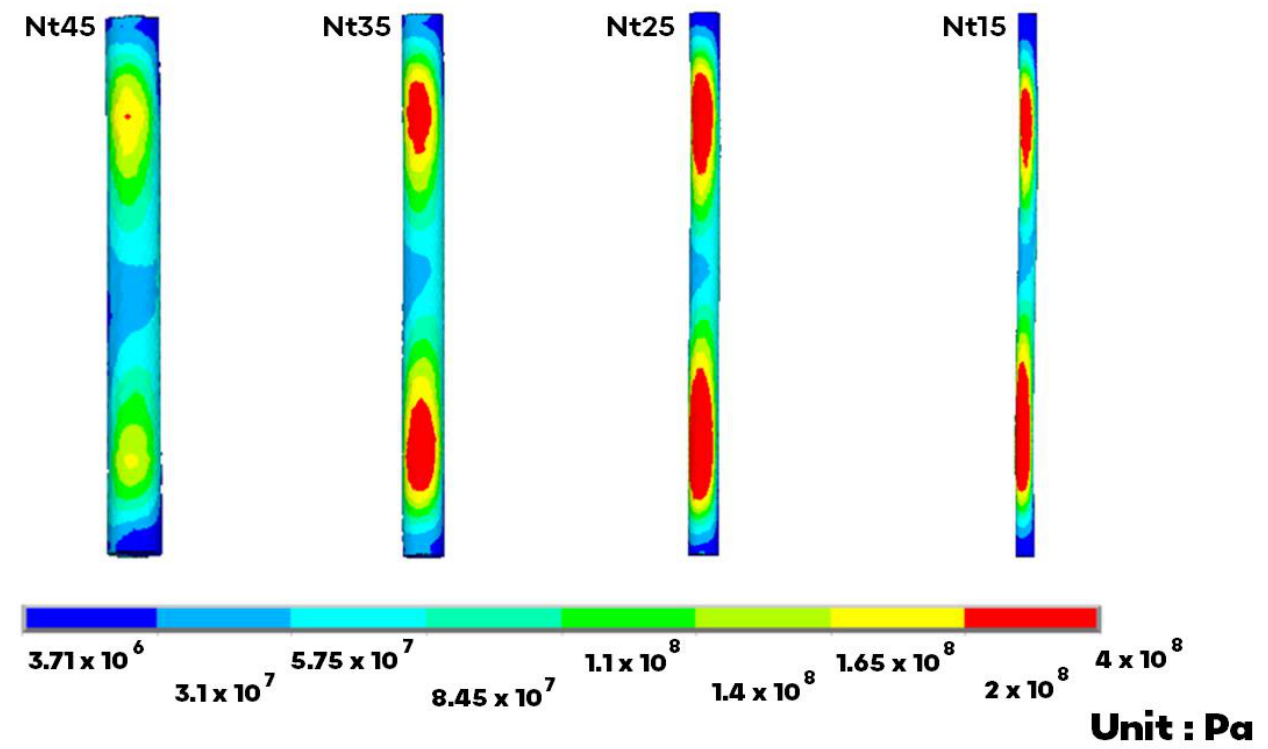
Figure 4. The von Mises stress on the inner NS markedly increased on the upper and lower portion. The maximum occurred on the Nt25 in torsion.